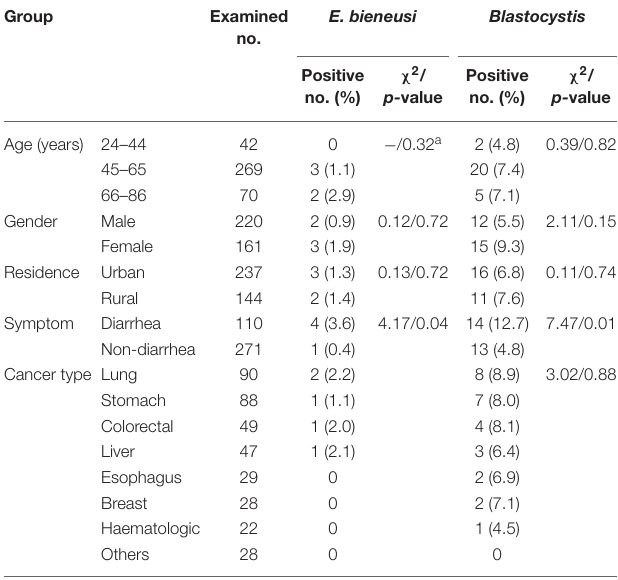
TABLE 1 | Prevalence of E. bieneusi and Blastocystis in cancer patients by age, gender, residence, clinical symptom, and cancer type. Group Examined